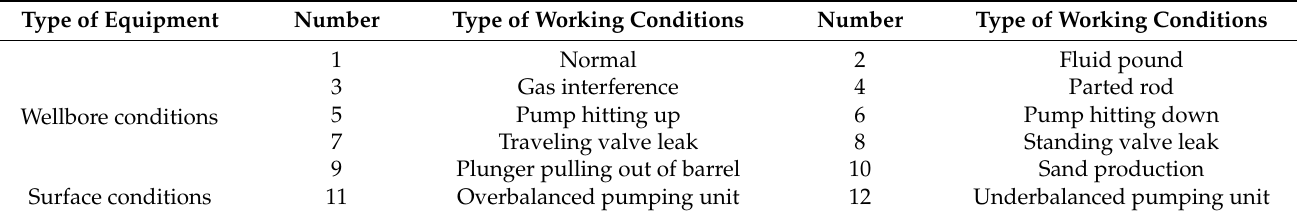
Table 1. Classification of working